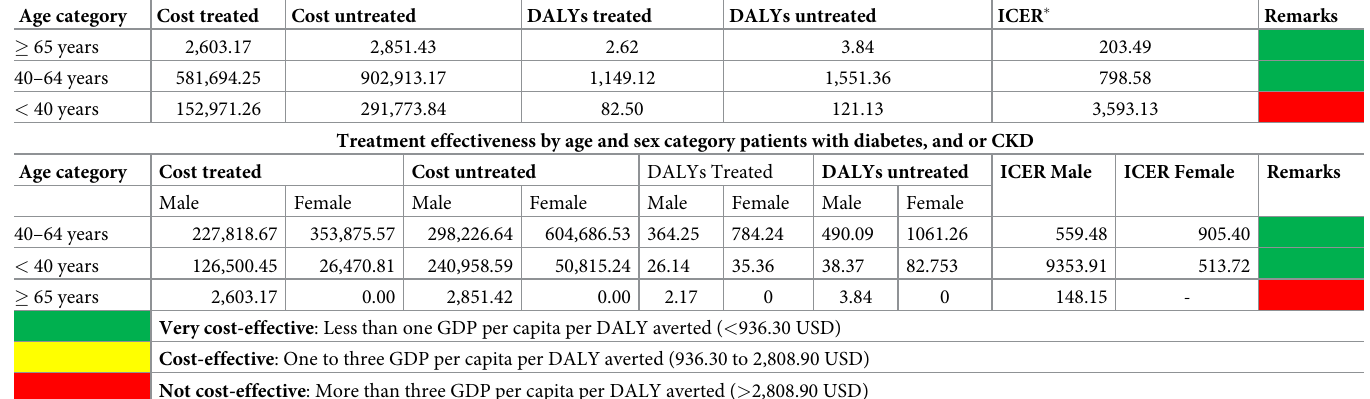
Table 5. Projected average annual incremental results of treating adults with untreated hypertension and diabetes, and or chronic kidney diseases above the Ages of 33 Years (2020–2030). Age